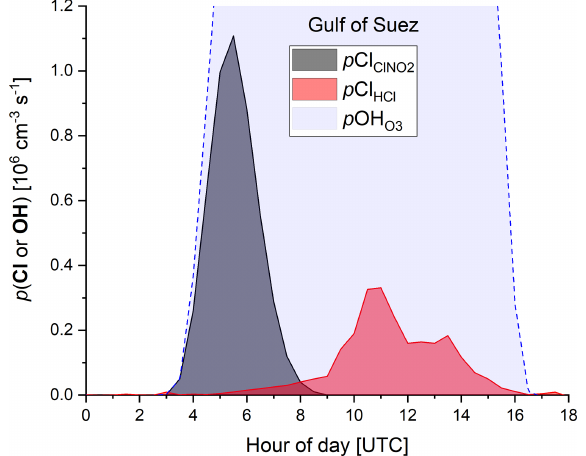
Figure 9. Production of Cl atoms (from ClNO 2 photolysis and HCl + OH) and OH radicals (from O 3 photolysis) over one diurnal cycle in the Suez Canal and Gulf of